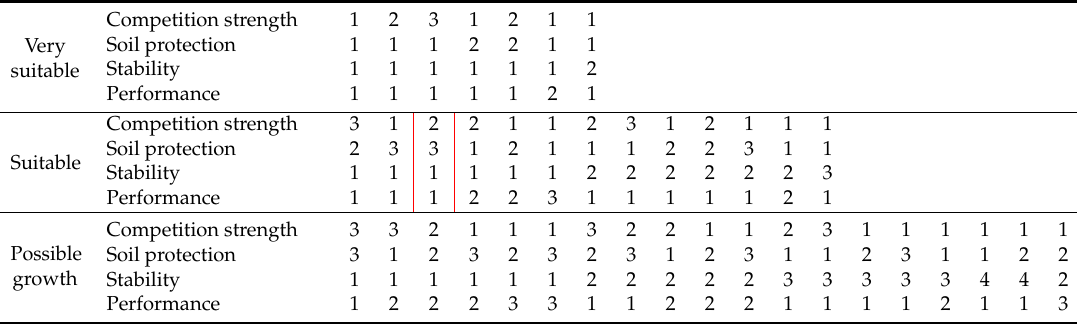
Table 1. Matrix for the assessment of tree species suitability for the classes ‘very suitable’, ‘suitable’, and ‘possible growth’. The attributes ‘competition strength’, ‘soil protection’, and ‘performance’ are assigned values from best (1) to poorest (3), and the attribute ‘stability’ from best (1) to poorest (5) [52]. As an example of how the matrix works, we enclose one possible combination in red. It shows that a tree species is considered as suitable on a regional-zonal unit when the competition strength is assigned a value of 2, soil protection a value of 3, and stability and performance with values of 1